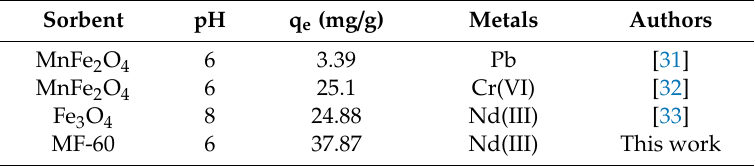
Table 1. Adsorption capacity of di ff erent metals with magnetic